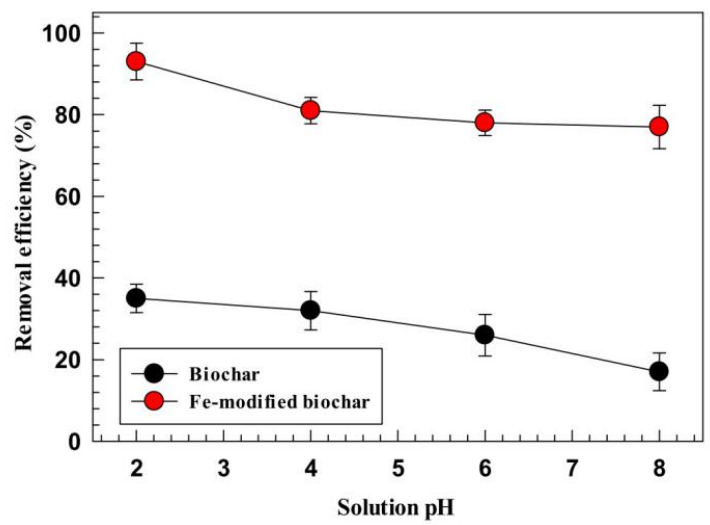
Figure 18. Effect of solution pH on the removal of As(V) using Biochar and Fe-modified biochar [39]. Reprinted with permission from Nguyen Thi Nham et al. (2019). Copyright 2019, IOP Publishing.